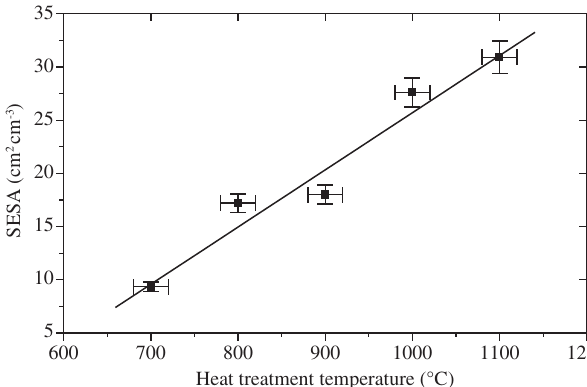
Figure 5. Cyclic voltammetric behavior of RVC electrode heat treated at 800 °C in 1 mM Ferrocyanide/0.1 M KCl. Each voltammogram is related to one sweep rate: A = 5 mV.s -1 ; B = 50 mV.s -1 ; and C = 500 mV.s -1